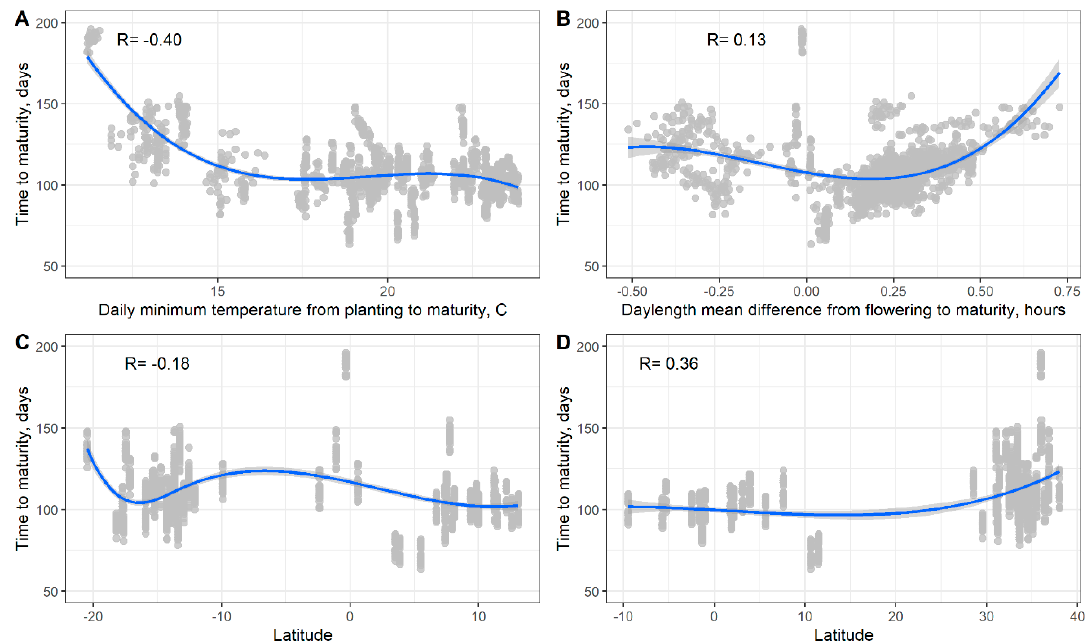
Figure 5. Soybean time to maturity (TTM) responses to crop cycle seasonal features used as the best predictors in a GAM. For visualization, panels ( A – D ) show the non-linear effects for each variable smoothed via natural splines (k = 3). Table 5. Evaluation of generalized additive models (GAM) used to predict soybean maturity timing (TTM).